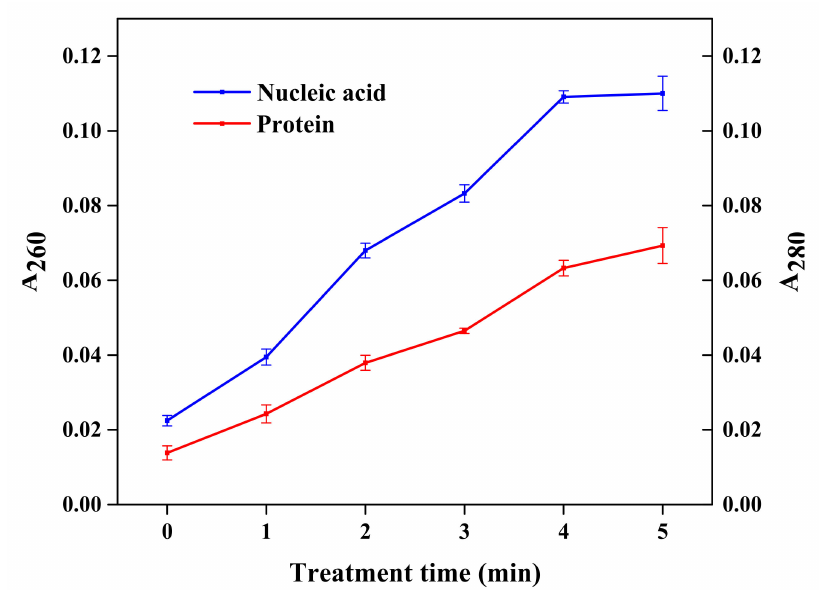
Figure 4. Effect of cold plasma treatment on the concentration of nucleic acid and protein in S. typhimurium